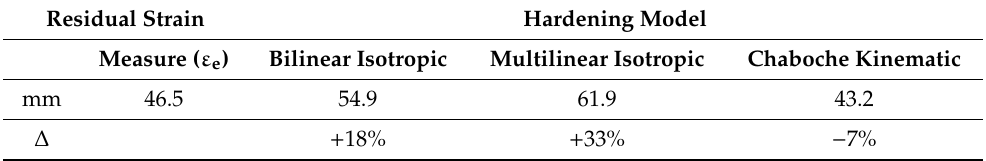
Table 2. Comparing measured and simulated residual strains (ε) for different hardening models .